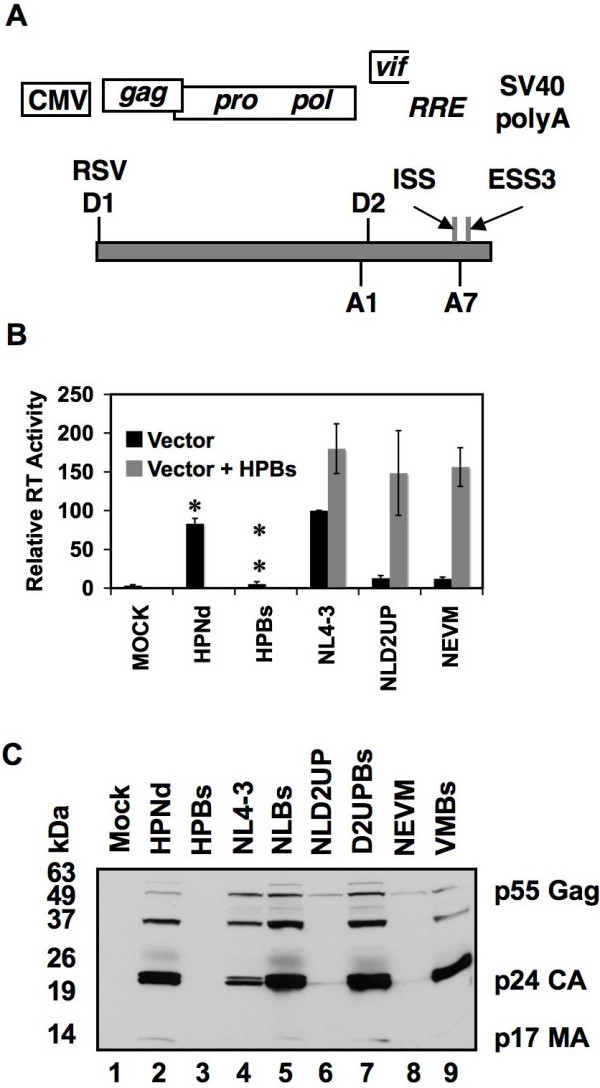
Restoration of HIV-1 virion production upon transient Gag, Gag-Pro, and Gag-Pro-Pol expression. (A) Open reading frames and signals contained within HPdBs. A representation of the HPdBs mRNA (grey box) is shown with the respective viral splice sites and splicing signals indicated. (B) Reverse transcriptase activity of cell-free supernatants from 293T cells transfected with the indicated plasmids, with or without the co-expression of the vector HPdBs. Black bars indicate the reverse transcriptase activity measured upon transient transfection of either HPNd, HPBs, or the indicated pNL4-3 derivative alone. Grey bars indicate the reverse transcriptase activity measured upon transient transfection of the indicated NL4-3 derivative along with HPBs. Reverse transcriptase activity represents the average of three independent experiments, normalized to the reverse transcriptase activity of supernatants from pNL4-3 transfected cells. Single asterisk indicates there is no significant difference when compared to NL4-3 transfected cells (p > 0.02 by Student's t-test) and double asterisk indicates there is no significant difference when compared to mock transfected cells (p > 0.2), from three independent experiments. (C) Protein from transfected 293T cells was subjected to Western blot analysis using serum from an HIV-1 infected patient. The HIV-1 Gag precursor (p55 Gag) and Gag proteolytic products (CA and MA) are indicated on the right.